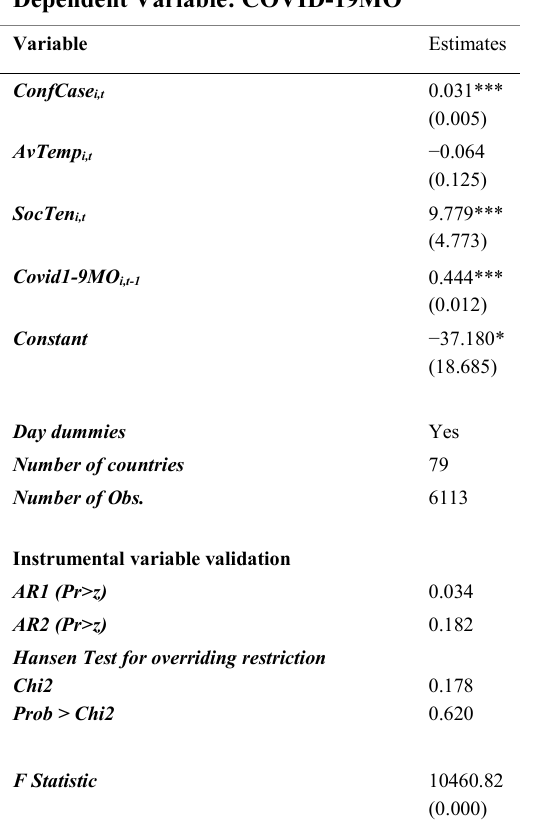
Table 3. Global System GMM One-Step Result Dependent Variable: